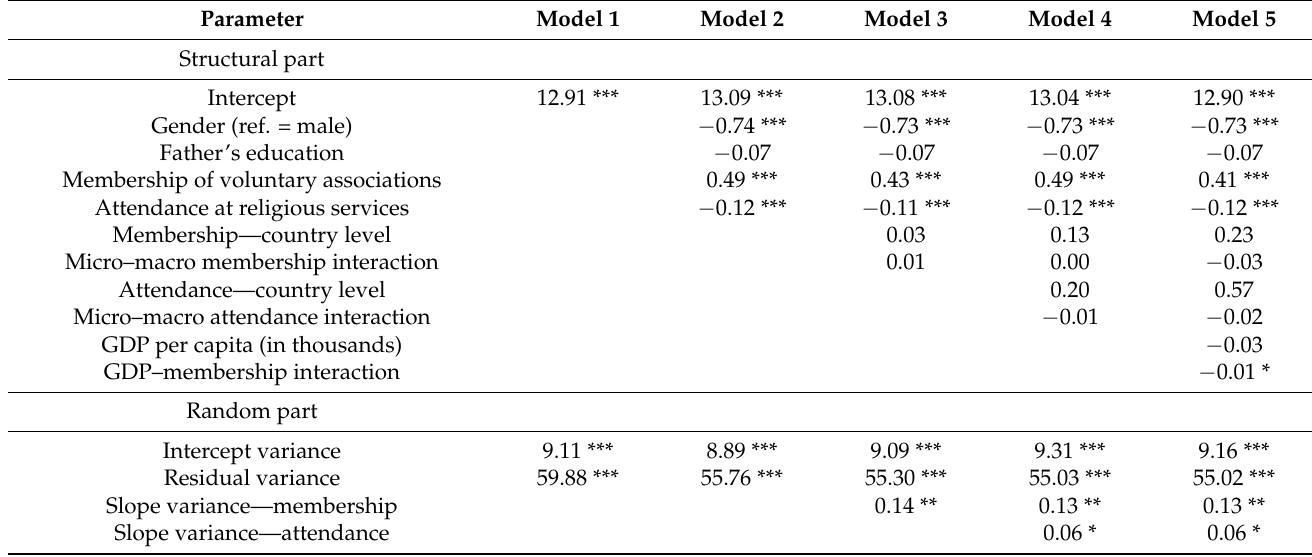
Table 2. Multilevel regressions on antisocial attitudes as the criterion